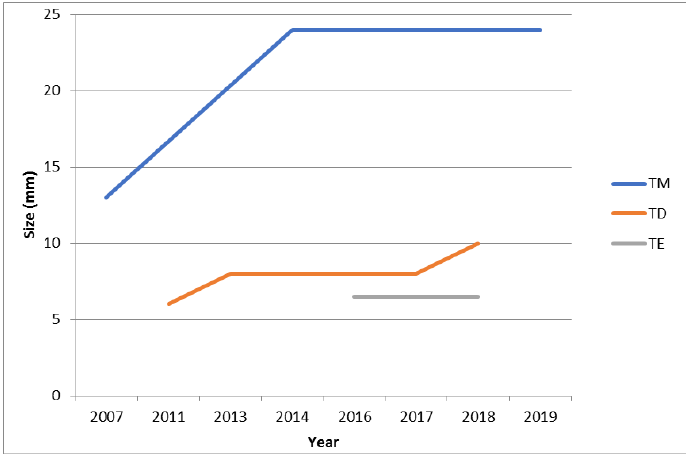
Figure 3. PGLs size change during follow-up. Abbreviation: PGLs = paragangliomas.